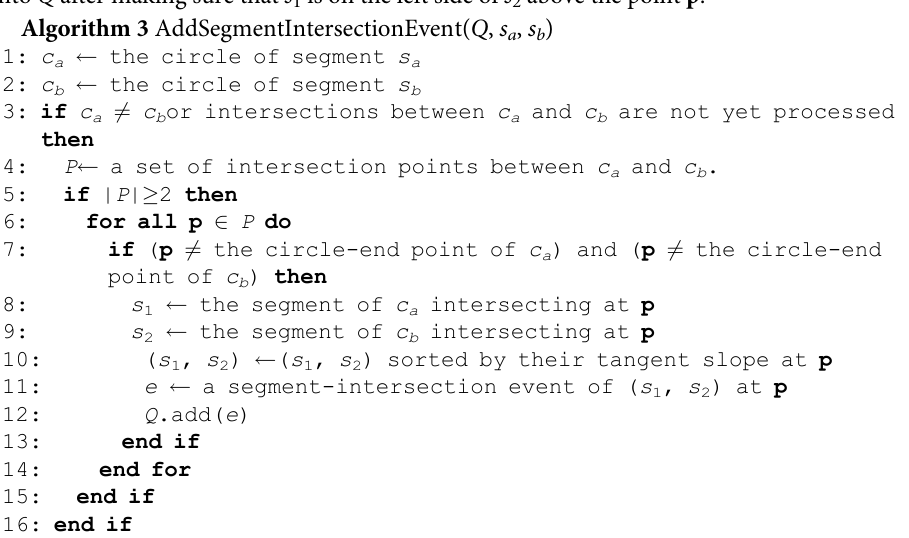
Determining solvent patches between sweep lines. Let us define a patch as a small region that is surrounded by two adjacent circle segments and two consecutive sweep lines. The func- patches on the CSAV and between two sweep lines determined by e mine if a patch is a solvent patch by counting the number of solvent circles and atom circles on it. Fig 3 illustrates the process of determining the solvent patches. Fig 3(A) shows the